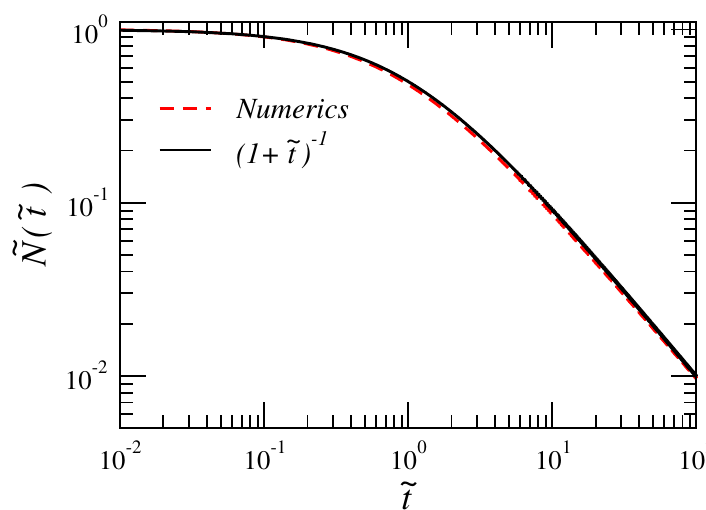
Figure 5: Numerical solution of Eq. (46) for ˜ N ( ˜ t ) (red-dashed line) compared with the form ˜ N ( ˜ t ) = ( 1 + ˜ t ) − 1 (solid black